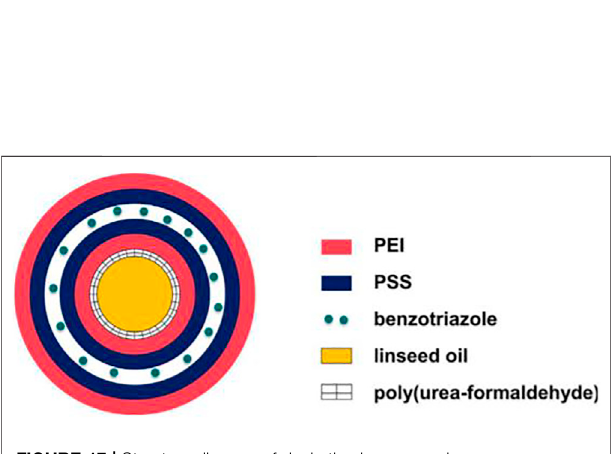
FIGURE 17 | Structure diagram of dual-stimulus responsive microcapsules (Leal et al., 2018).